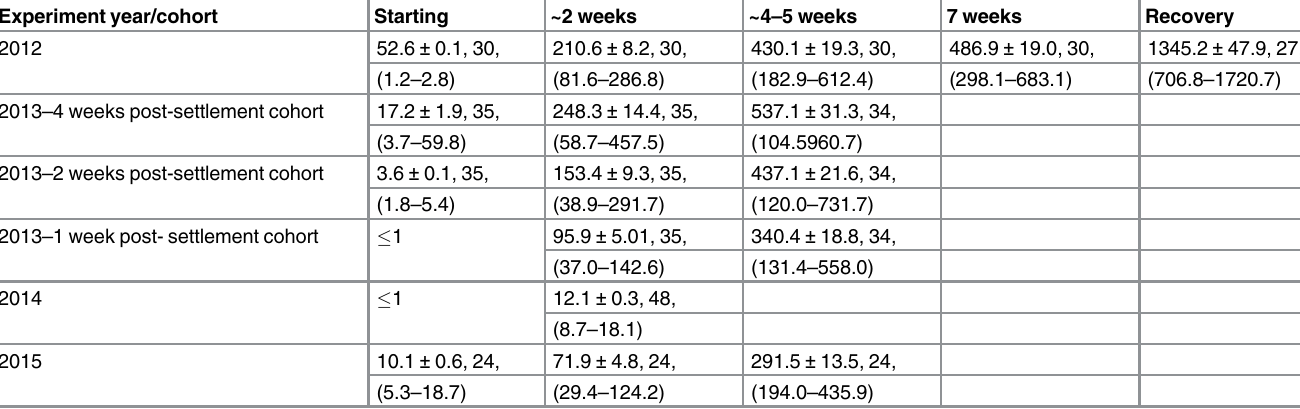
Table 2. Starting, ending, and recovery shell area of oysters.